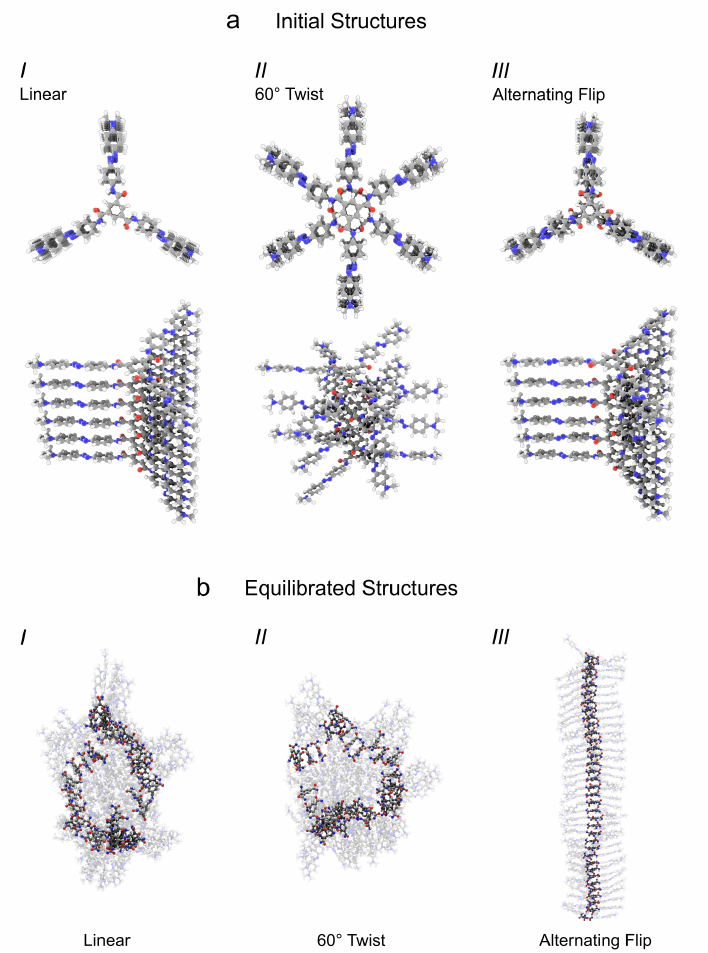
Figure 5. ( a ) The three considered initial structures of the pre-assembled columnar TrisAzo clusters, here with N = 6 (top and angled view). From left to right: I —linear arrangement, II —60° twist (or in-plane rotation) between neighboring molecules, and III —linear arrangement with alternating molecules flipped by 180°. ( b ) Simulation snapshots of the resulting equilibrium geometries, taken at the end of the production runs. The largest considered clusters are shown ( N = 36). The BTA linkers are highlighted for better visibility of aligned sections and